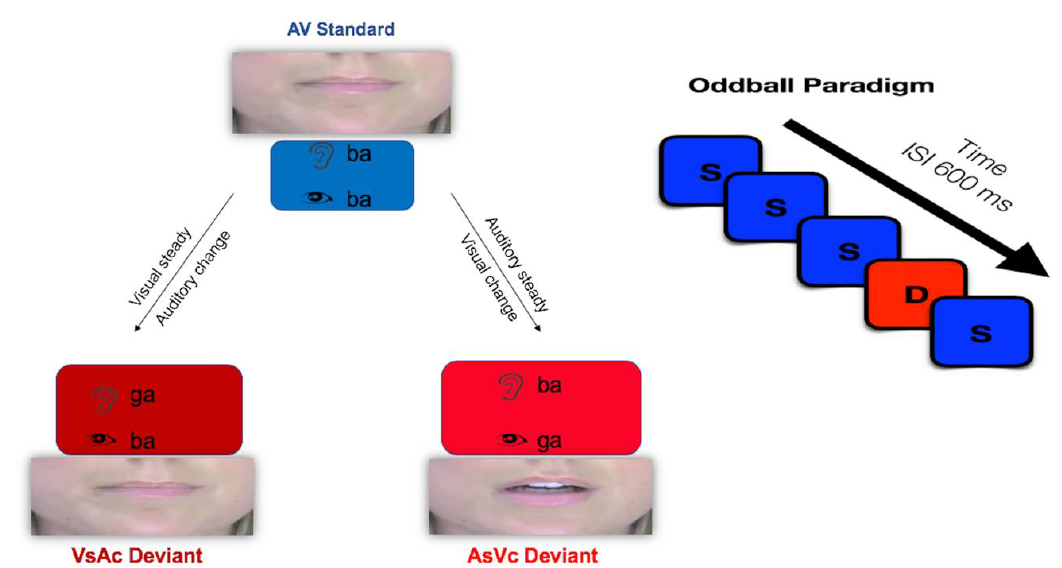
Figure 1. Audiovisual oddball paradigm. In the auditory steady–visual change (AsVc) condition, the visual aspect of the stimulus changes. In the visual steady–auditory change (VsAc) condition, the auditory aspect of the stimulus changes.